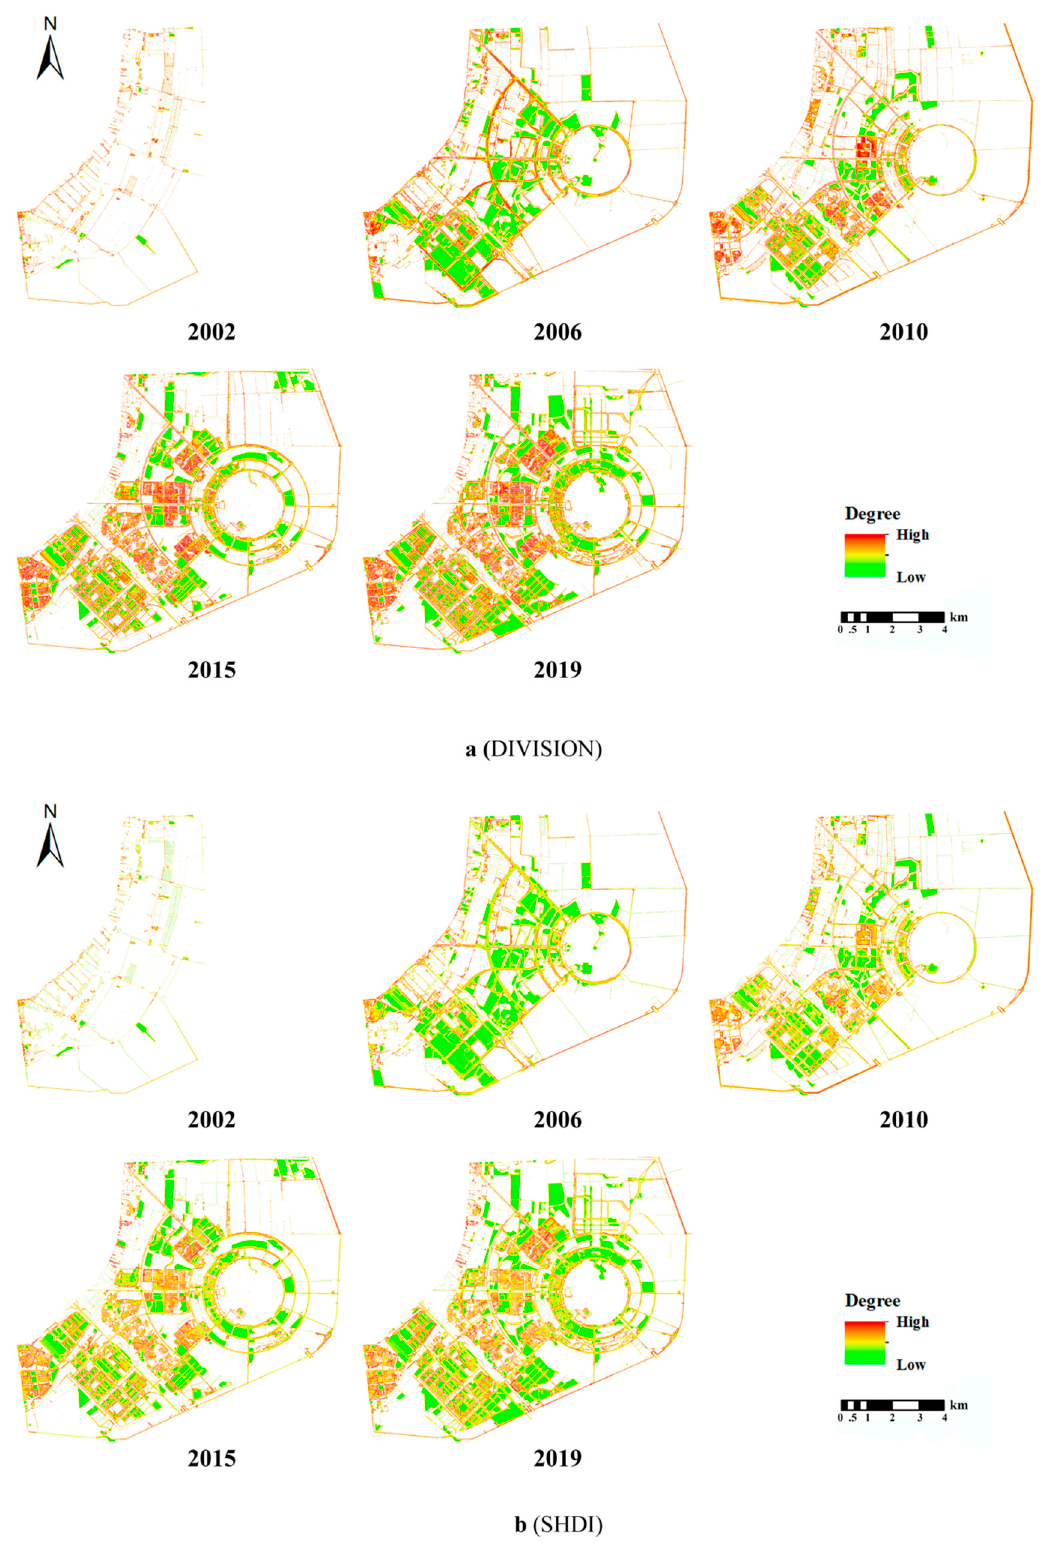
Figure 5. Spatial distribution of landscape fragmentation ( a ) (DIVISION) and diversity ( b ) (SHDI) of low-level habitats.